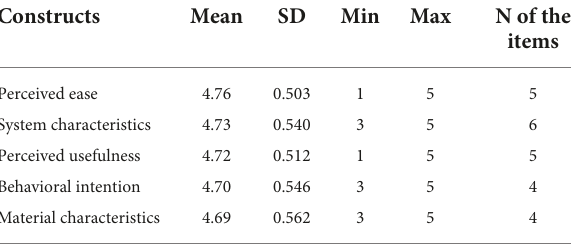
TABLE 4 Descriptive statistics of the Technology Acceptance Model (TAM).